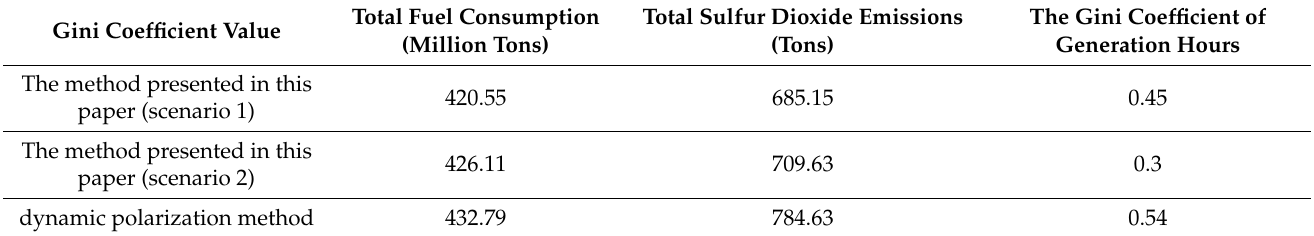
Table 2. Case study results according to the method presented in this paper and the dynamic difference